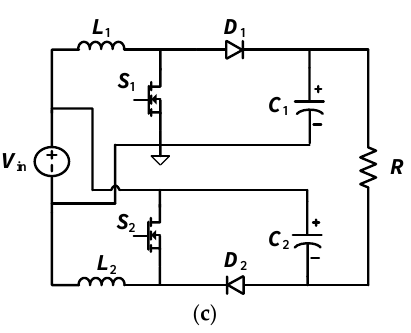
Figure 2. Conventional boost converter topologies. ( a ) The cascade boost topology, ( b ) the boost topology with voltage multiplier cells (VMC), and ( c ) dual boost converter.